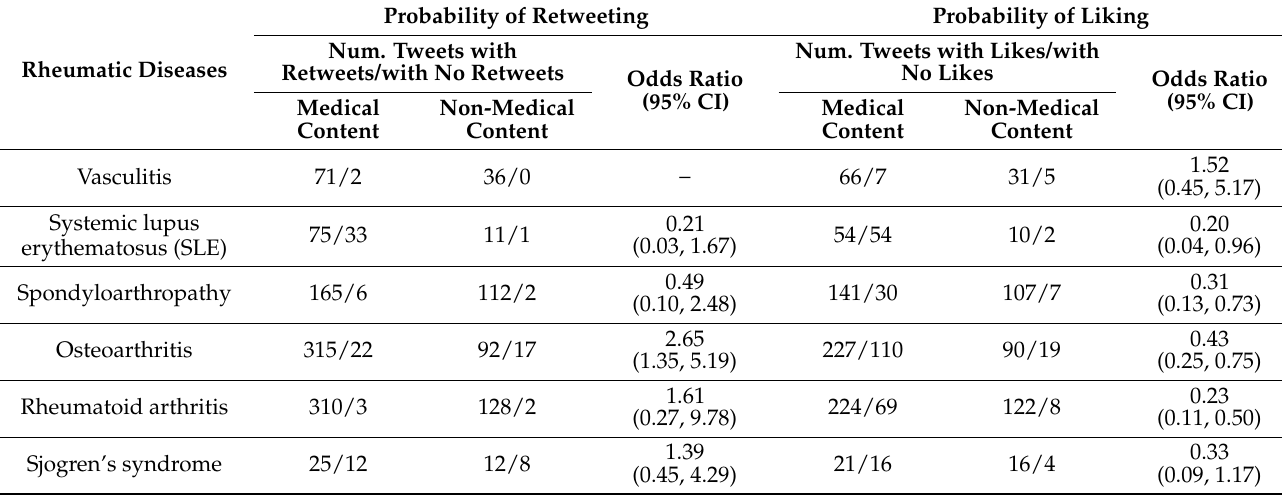
Odds ratio and 95% confidence intervals estimated by logistic regression models. NOTE: Those that reach statistical significance are